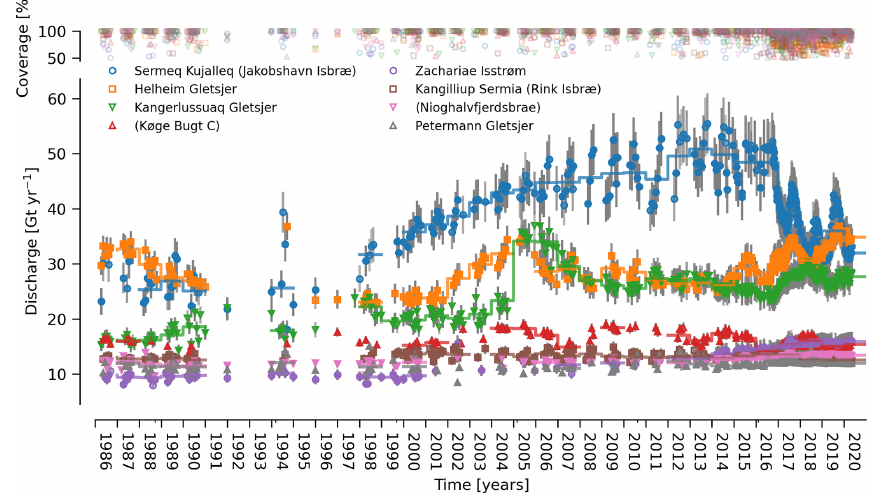
Figure 6. Bottom panel: time series of ice discharge showing the eight major discharging glaciers from Fig. 1. Same graphical properties as Fig.